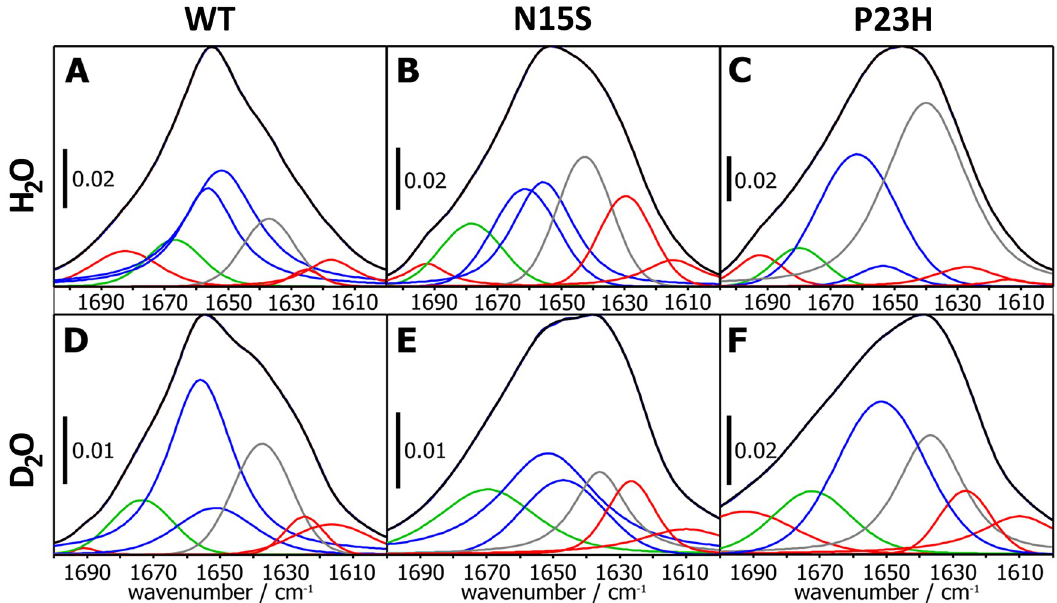
Fig 4. The FTIR amide I band region along with the deconvoluted spectra corresponds to different secondary structure fractions of the three samples. A-C: Rhodopsin in H 2 0, D-F: Rhodopsin in D 2 0: A, D: WT; B, E: N15S; and C, F: P23H. Bands assigned to β -sheets are indicated red , β -turns green , α -helices blue , and random coil grey .